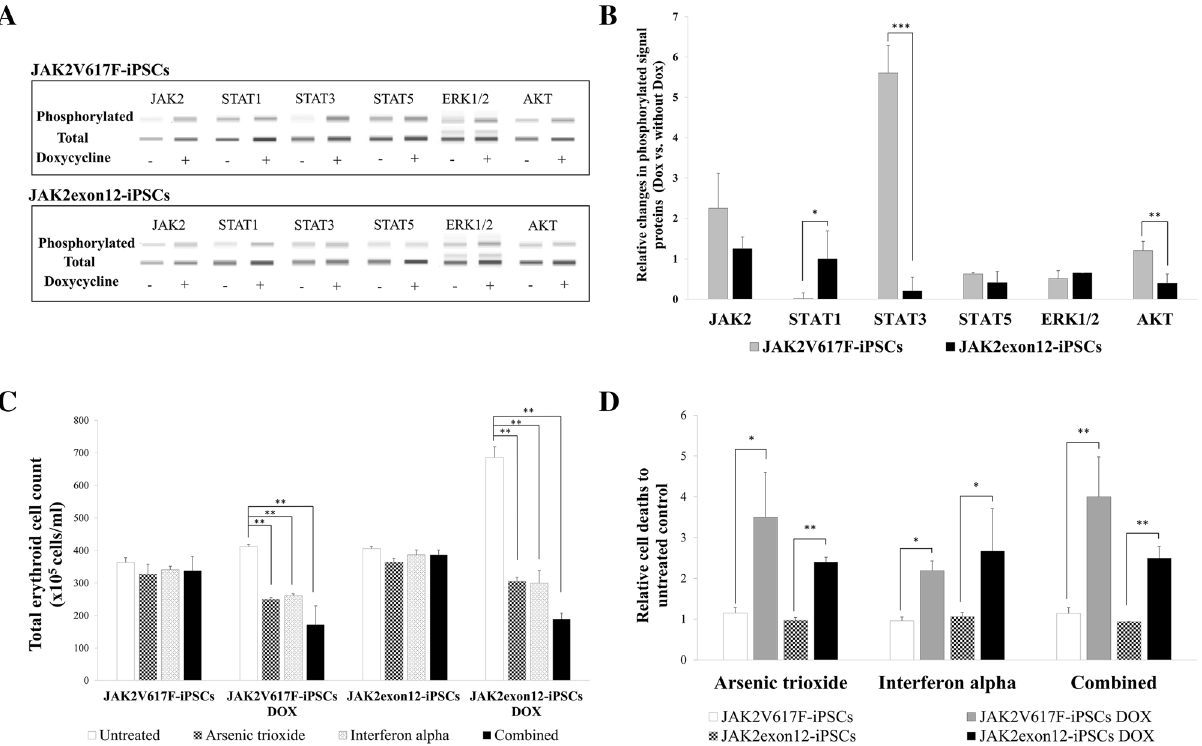
Figure 5. Signal transduction and drug treatment of modified induced pluripotent stem cells (iPSCs). ( A ) The capillary Western immunoassay of phosphorylated and total signaling proteins which were JAK2, STAT1, STAT3, STAT5, ERK1/2 and AKT in the absent and presence of doxycycline in JAK2V617F-iPSCs and JAK2exon12-iPSCs. Each band was electrophoresed in a separate capillary tube. The full blot is presented in the Supplementary Fig. S2B. ( B ) The relative changes of phosphorylated signaling proteins after doxycycline induction in JAK2V617F-iPSCs and JAK2exon12-iPSCs compared with those without doxycycline. The levels of phosphoproteins were corrected by the amounts of respective total proteins. ( C ) Erythroid cell numbers after incubations without (untreated) vs. with arsenic trioxide, interferon alpha and the combination of both drugs. ( D ) The relative increases in numbers of apoptotic cells in modified iPSCs in the presence of arsenic trioxide, interferon alpha and the combination of both drugs. Data were presented as mean ± SD from three independent experiments. The asterisks (*), (**) and (***) denoted p < 0.05, p < 0.01 and p < 0.001,